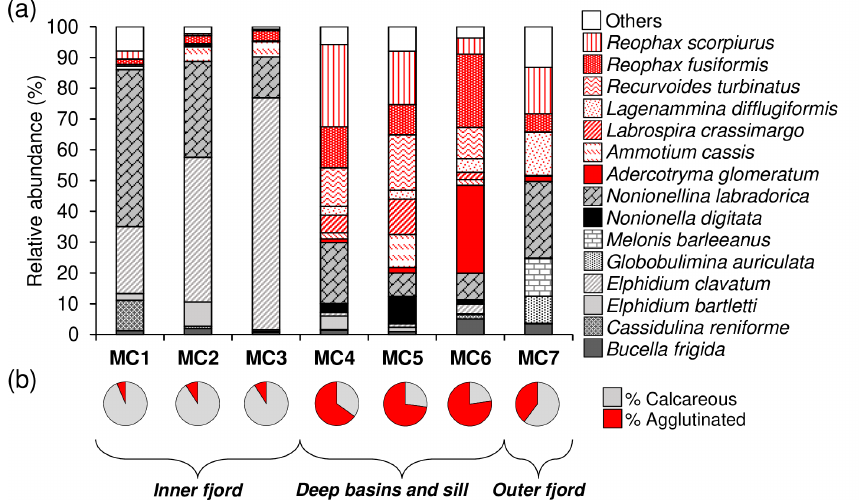
Figure 3. (a) Species relative abundances of the total living fauna ( > 150µm fraction) in the 0 to 5cm core top sediment at each station and (b) the agglutinated species (in red) vs. calcareous species (in grey) ratio.